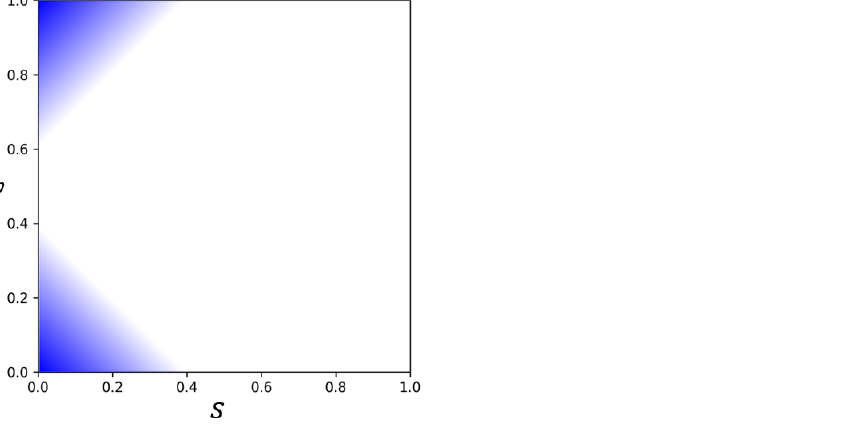
Figure 7. Saturated region: the upper highlighted area and the lower highlighted area are considered as the oversaturated region and the undersaturated region, respectively.